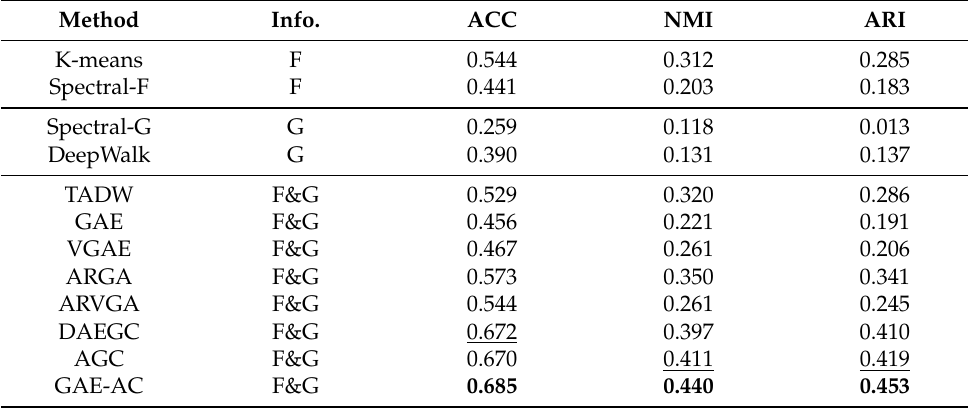
Table 3. Node Clustering Results on Citeseer Dataset.